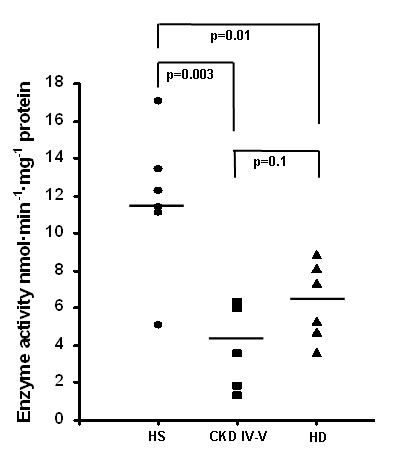
Cytochrome c oxidase (COX) activity in peripheral blood mononuclear cells (PBMC) from healthy subjects (HS), chronic kidney disease (CKD IV–V) and hemodialysis (HD) patients. Dot-plot represents the mean ± SD of COX enzymatic activity measured by following the oxidation of ferrocytochrome c at 550-540 nm in total cell lysate of 6 HS, 6 CKD and 6 HD. Activity was significantly lower in CKD IV–V and HD compared to HS. The line represents the mean value.